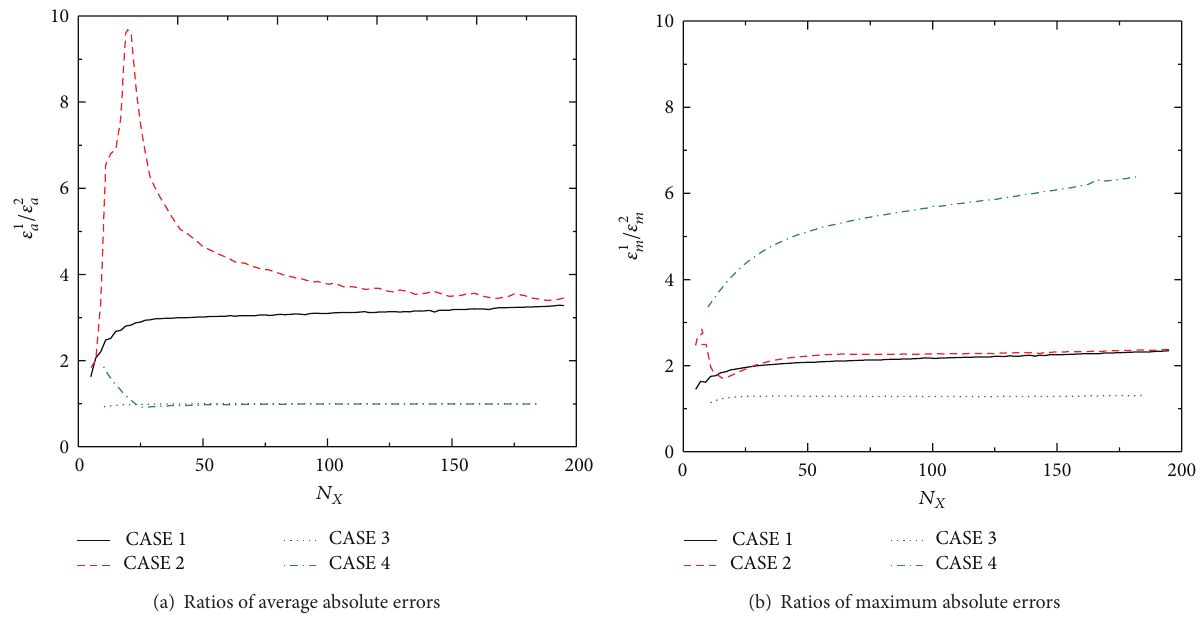
Figure 8: Ratios of